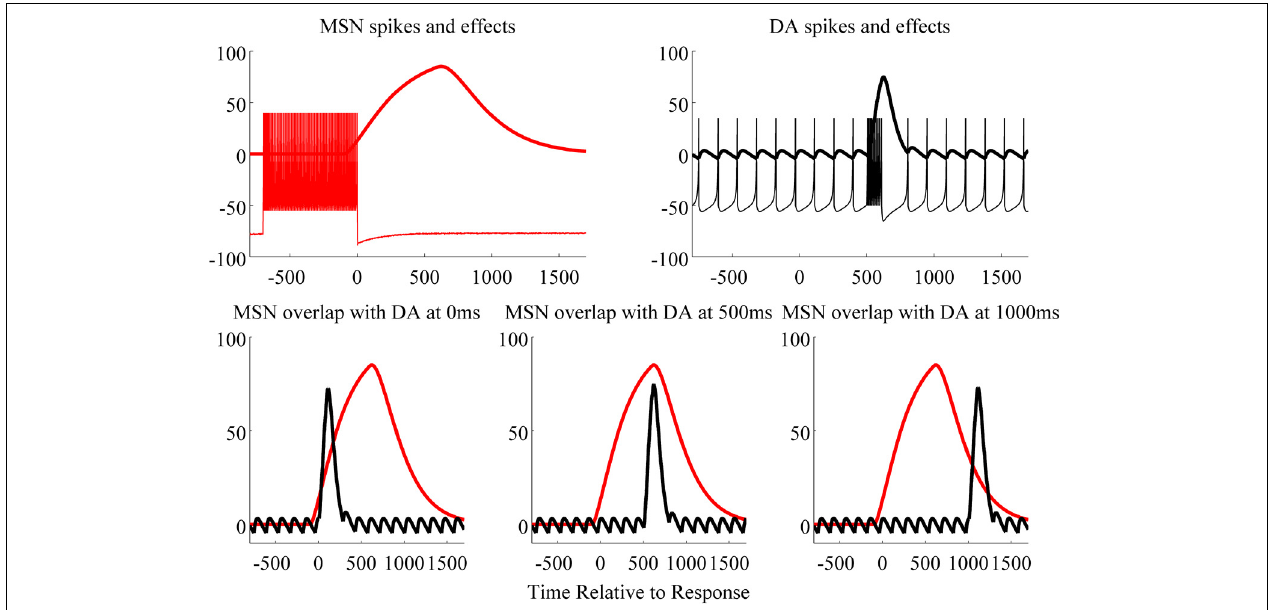
FIGURE 3 | Top: MSN spikes and postsynaptic effects of stimulus presentation (response terminated after 700ms; left), and DA spikes and postsynaptic effects for a correct feedback (delayed 500ms post response/stimulus, right). The x-axis indicates the time from response (set to 0): negative values are before response, and positive values are after